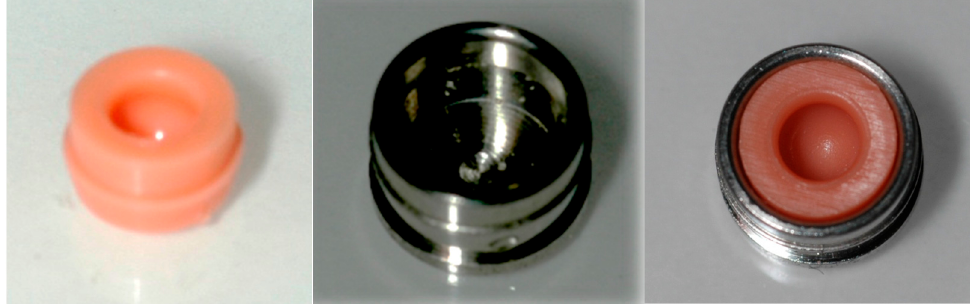
Figure 2. Silicone liner and metal housing.